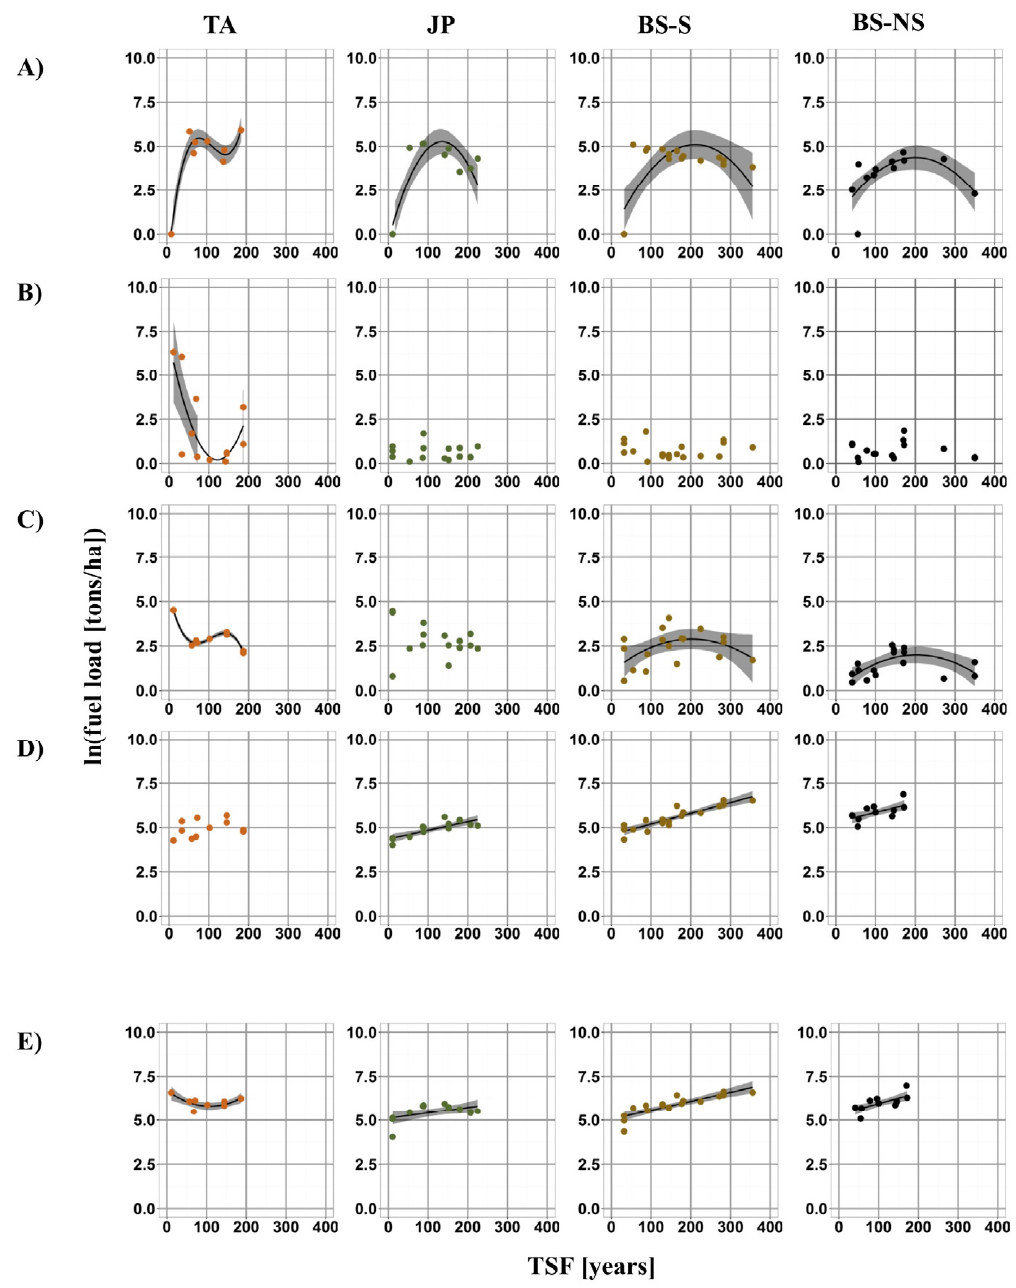
Figure 2. Changes in loads of ( A ) tree; ( B ) fine aerial vegetation (herbs and shrubs); ( C ) dead woody debris (DWD); ( D ) duff; and ( E ) total fuel ( A + B + C + D ) with TSF for TA, JP, BS-S, and BS-NS dominated forests. Fuel loads were logarithmically transformed and are represented by color points. The black line expresses the significant relationship ( p -value ≤ 0.05) in the polynomial regression analysis and the grey shape corresponds to the regression standard error.